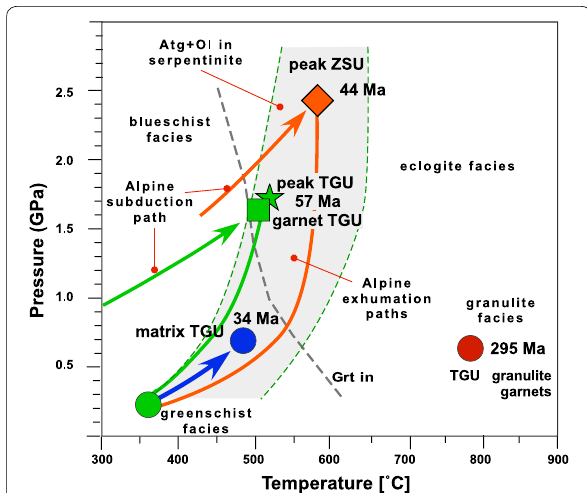
Fig. 11 Summary of metamorphic conditions and ages: Prealpine granulite facies metamorphism at 295 Ma (red point). Alpine subduction related high-P low-T metamorphism: Garnet in TGU at 57 Ma: Peak P – T conditions reached by the TGU (green symbols) and the ZSU (orange symbols) in the Zermatt area (average from Bucher et al. 2005; Angiboust et al. 2009; Bucher and Grapes 2009; age from Rubatto et al. 1998). Possible prograde paths for alpine subduction metamorphism and subsequent exhumation is constrained by the presence of stable Ol Atg in the ZSU serpentinites (Li et al. + 2004a). Exhumation of TGU and ZSU terminated at greenschist facies conditions (green circle). The conditions calculated for the matrix recrystallization of the TGU were reached along a prograde path (blue symbols) starting at the exhumation path and attaining the P – T maximum for this event not later than 34 Ma ago (Amato et al. 1999). The final exhumation path of both units is not